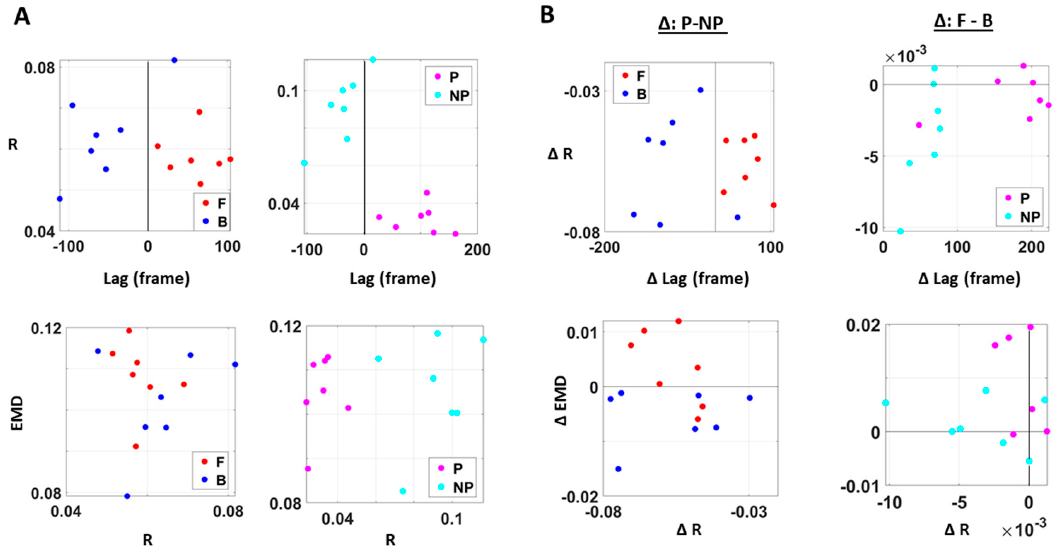
Figure A5. Different viewpoints of the 3D graphs in Figure 8. ( A ) Different viewpoint of graphs in Figure 8B. ( B ) Different viewpoints of graphs in Figure 8C (left) and Figure 8D (right).